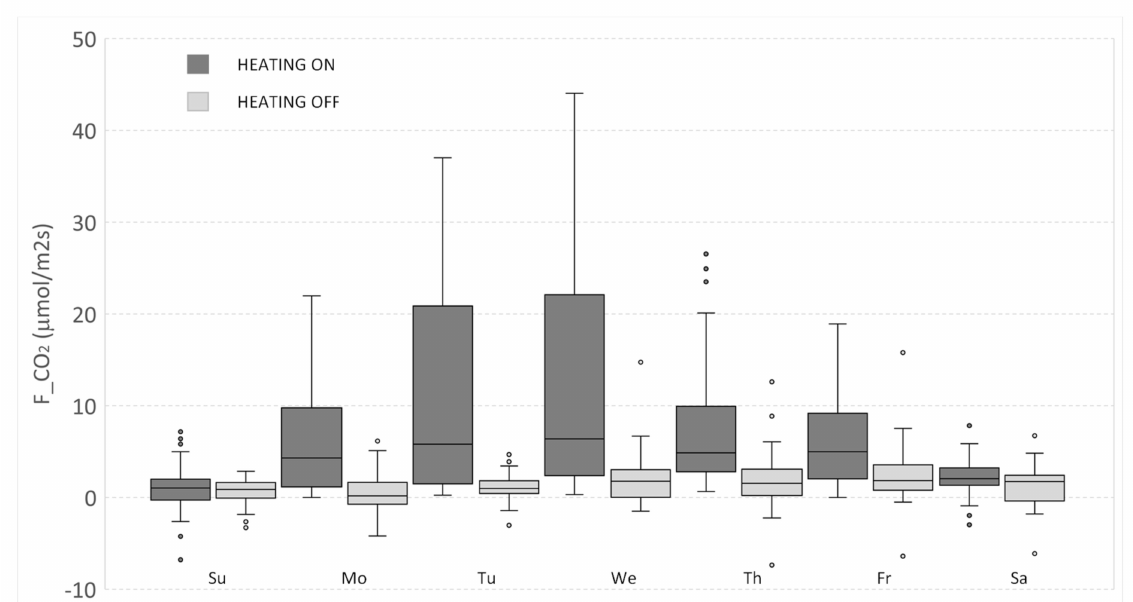
Figure 11. Weekly course derived from daily CO 2 fluxes from Sunday to Saturday in March (heating ON, dark grey box) and April (heating OFF, light grey